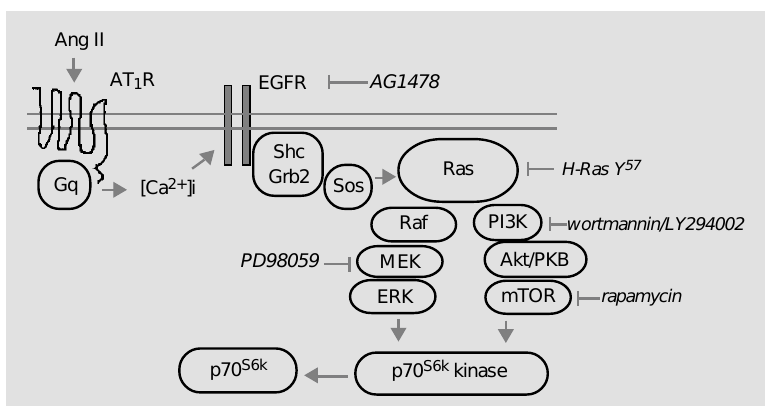
Figure 4 - Hypothetical pathways involved in the phosphorylation of p70 S6k by angiotensin II (Ang II). According to this model, activation of the putative S6 kinase (S6k) by Ang II requires two separate pathways which bifurcate at the point of Ras activation through transactivated epidermal growth factor receptor (EGFR). AT 1 R, Type 1 Ang II receptor; ERK, extracellular signal-regulated kinase; PKB, protein kinase B; PI3K, phosphatidyl inositol-3-kinase; MEK, MAPK